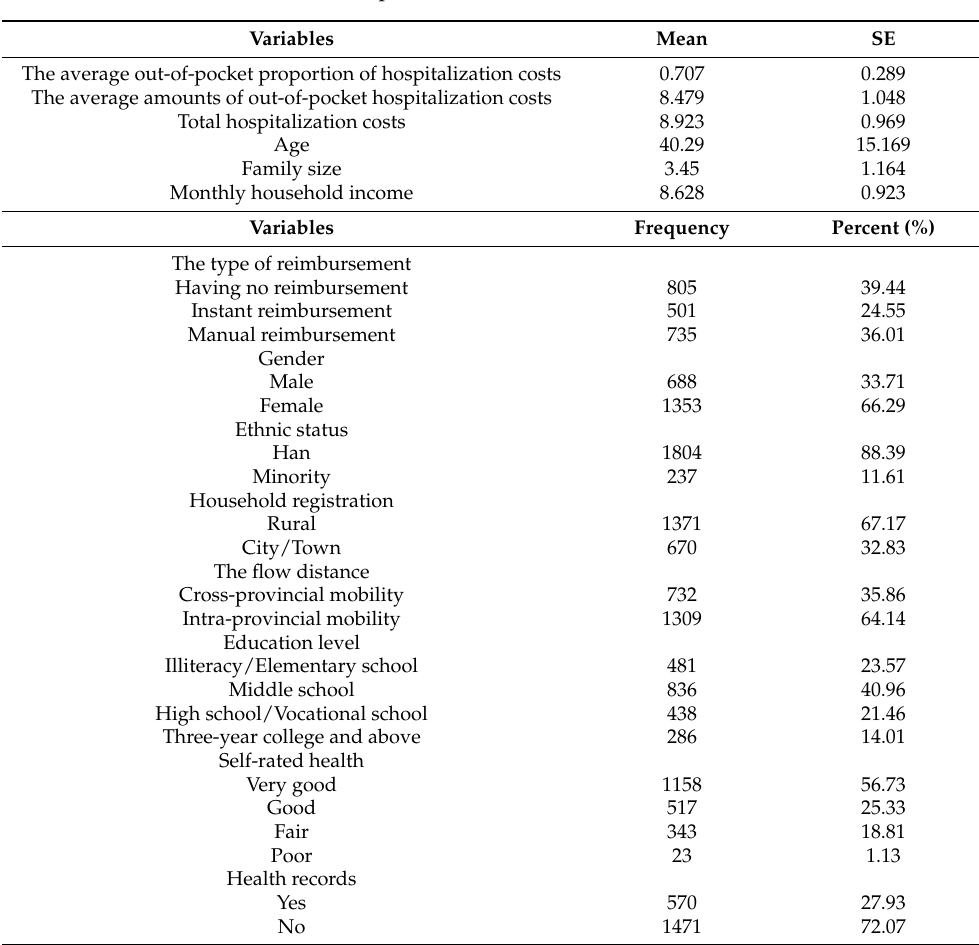
Table 1. Variable definition and descriptive